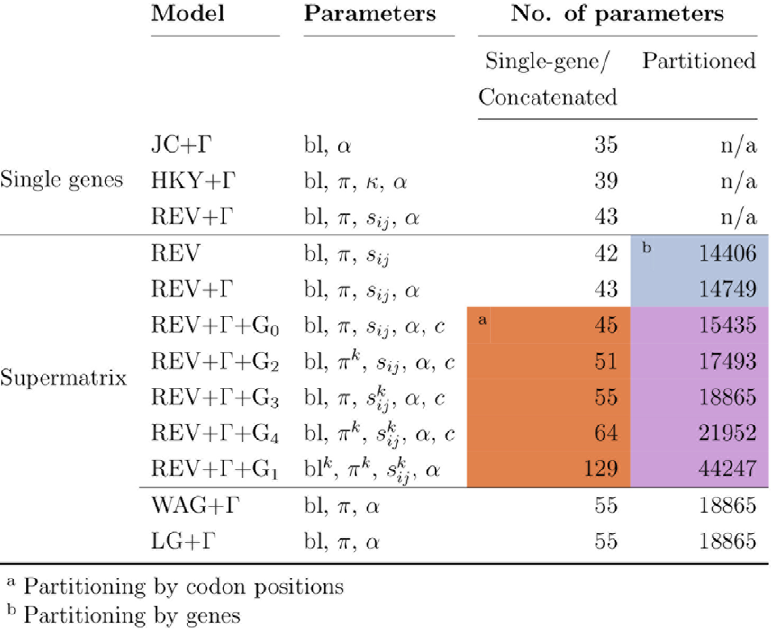
Figure 1. Evolutionary models used and the number of parameters estimated per model. The number of parameters for partitioned analyses is based on the dataset size of 351 genes, where each parameter is estimated separately for each gene. a is the shape parameter of the gamma distribution, bl are the branch lengths, k and s ij are the rate ratio parameters (see Methods) and p are the nucleotide frequencies. When the Mgene options in baseml are used, c represents two scaling factors for proportional branch lengths at different codon positions and the ‘‘ k ’’ superscript indicates that in these models, those parameters are estimated separately for each codon position. The area shaded in red (note a) indicates partitioning by codon positions, blue (note b) indicates partitioning by genes and purple indicates partitioning by both codon positions and genes.